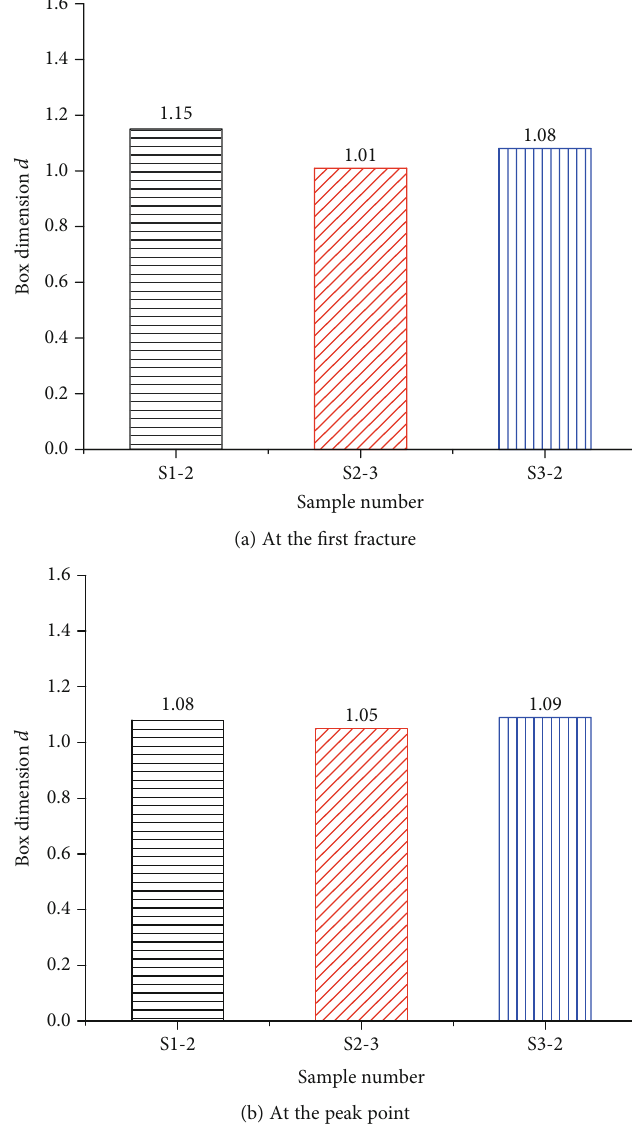
Figure 10: The fractal dimension of the sandstone surface fracture distribution in zone